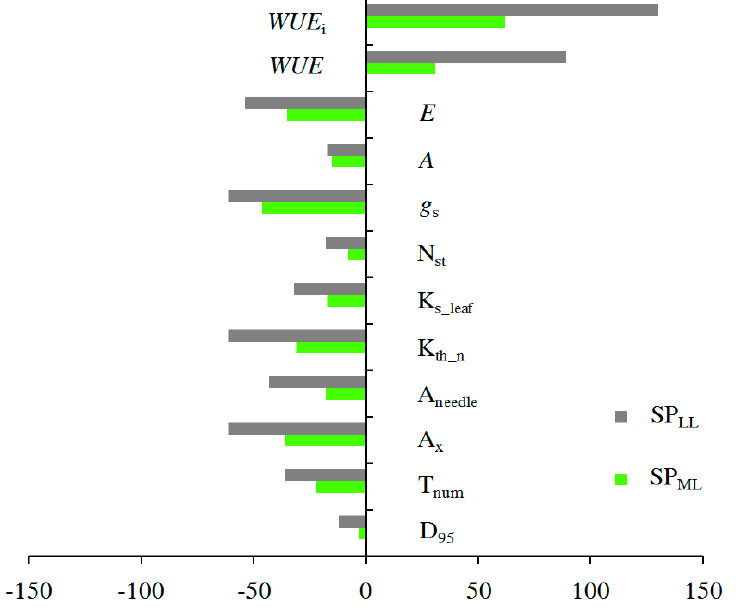
Figure 1. Variability (%) of needle xylem traits and leaf gas exchange parameters under shaded conditions in the clear-cut SP ML and the forest SP LL relative to full sunlight in the clear-cut SP HL . The highest values of tracheid lumen diameter (D 95 ), number of tracheids per needle (T num ) and xylem area per needle (A x ), needle area (A needle ), theoretical needle hydraulic conductivity (K th_n ) and theoretical leaf-specific hydraulic conductivity (K s_leaf ), number of stomata per unit needle area (N st ), stomatal conductance ( g s ), rates of photosynthesis ( A ) and transpiration ( E ) and, on the contrary, the lowest values of photosynthetic water use efficiency ( WUE i , WUE ) were noted in Scots pine trees growing in the clear-cut SP HL and getting sufficient amounts of light. At the same time, the values of theoretical needle xylem-specific hydraulic conductivity (K s_xylem ) were similar ( p > 0.05) in habitats with high (clear-cut site), medium (shading in the clear-cut), and low (forest canopy) light levels (Table 1).